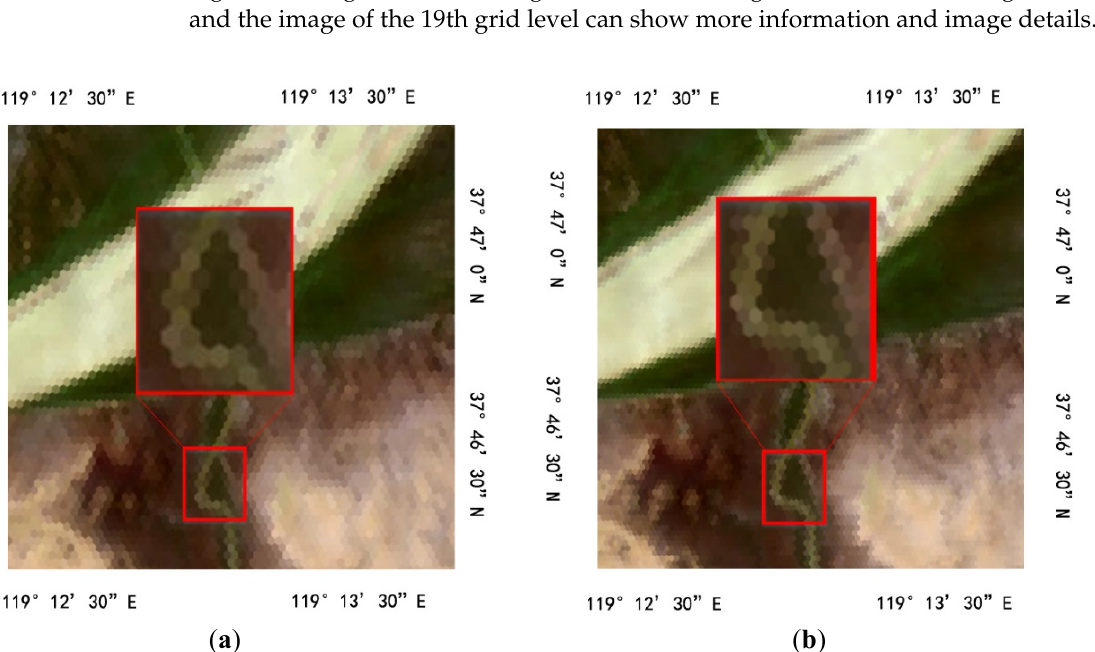
Figure 12, the grid unit side length ratio of the 19th grid level and the 18th grid level is 1:2, and the image of the 19th grid level can show more information and image details.